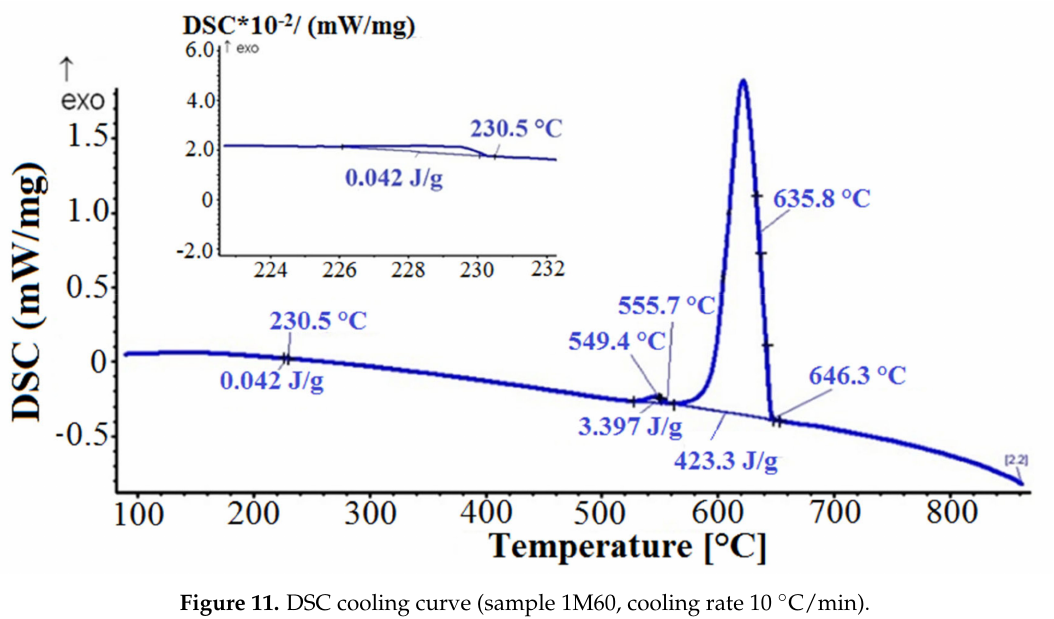
Figure 11. DSC cooling curve (sample 1M60, cooling rate 10 ◦ C/min).